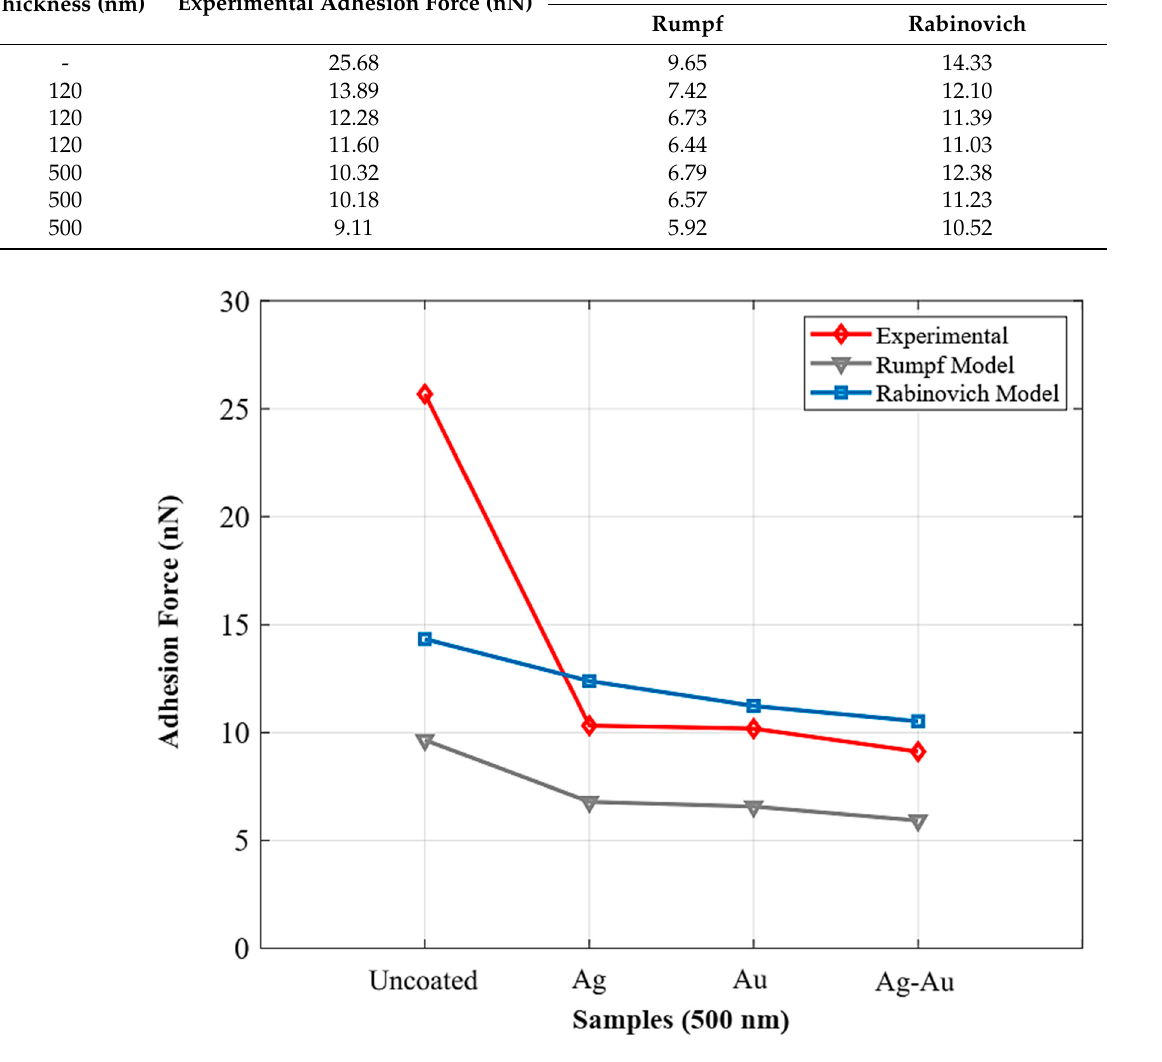
Figure 10. Comparison of adhesion force values between theoretical and experimental approaches to samples with 500 nm thickness.